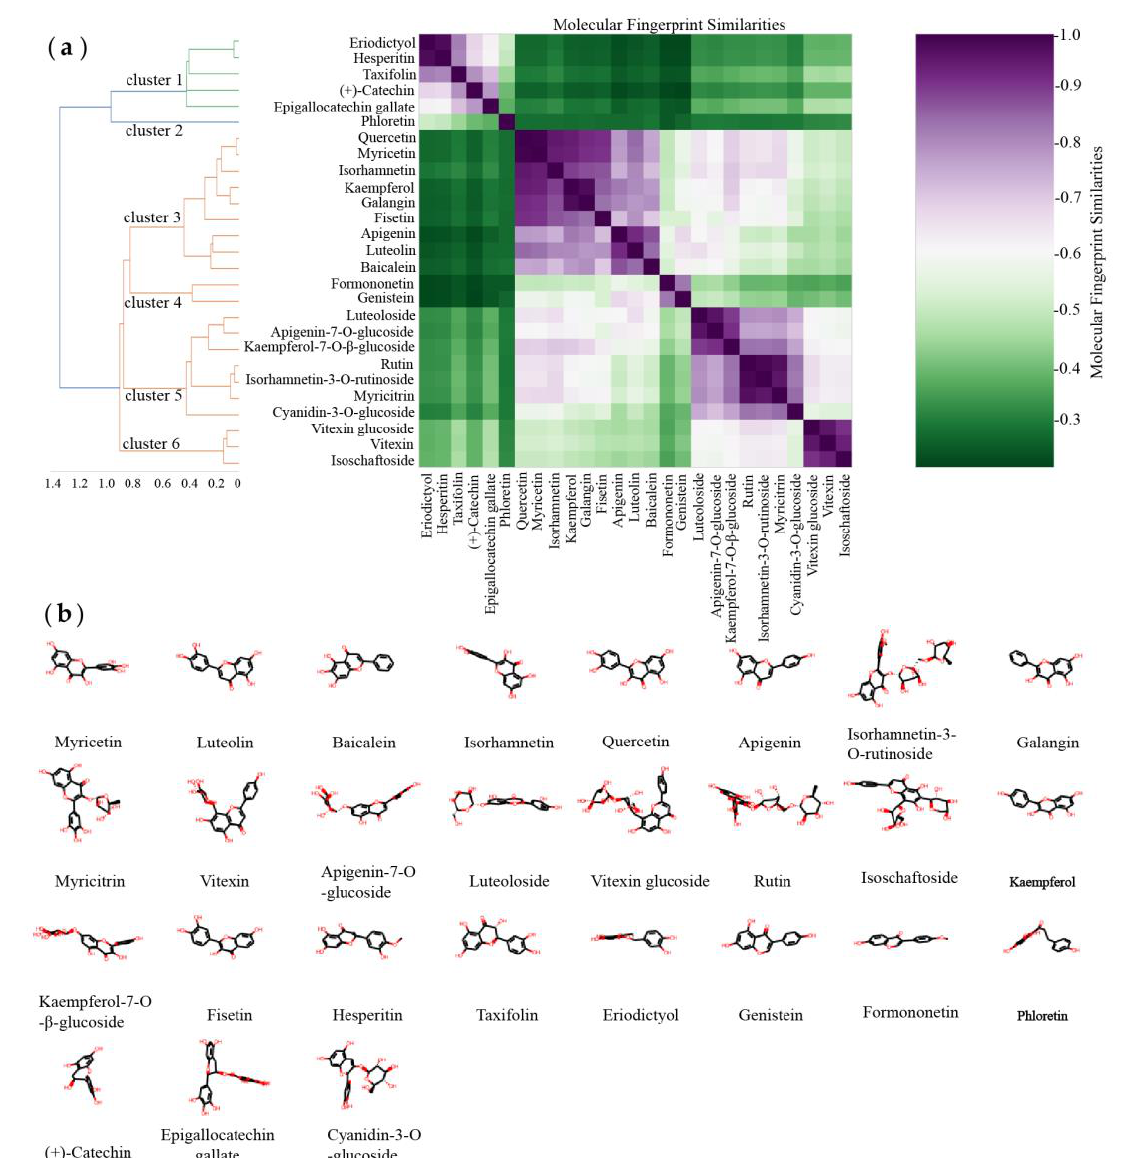
Figure 1. ( a ) Hierarchical clustering of molecular fingerprint similarities of dietary flavonoid com- pounds. ( b ) Structures of 27 dietary flavonoid compounds.